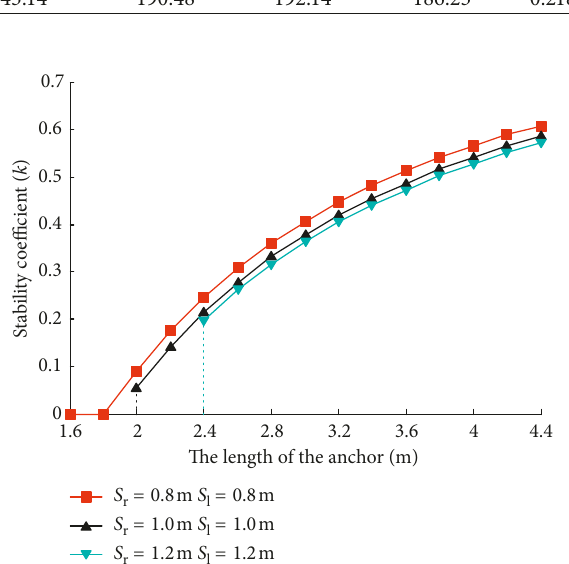
Figure 8: Influence of the anchor length and spacing on the stability of surrounding